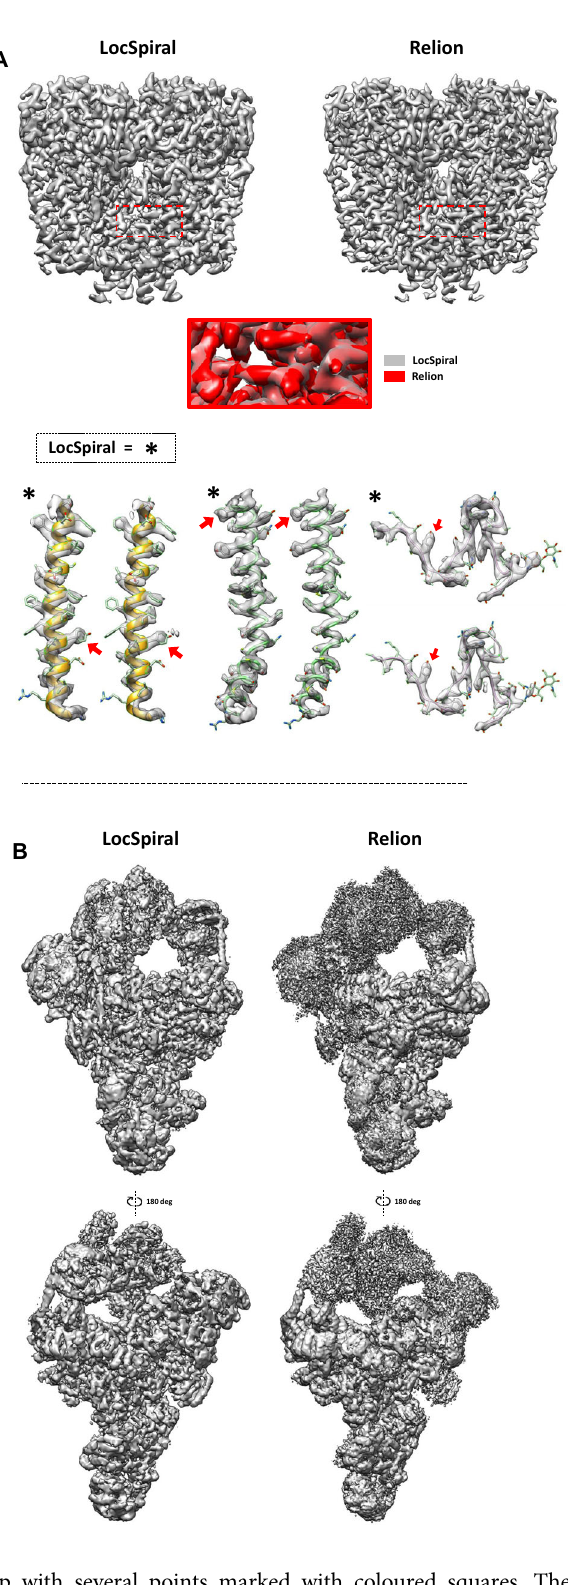
map with several points marked with coloured squares. These points show parts of the map that correspond to clear spliceosome densities (green and red), fl exible and low- resolution spliceosomal regions (yellow and blue) and back- ground (magenta). Figure 2B shows the corresponding Guinier plots at these locations. Solid lines represent measured values of the logarithm of SNR-weighted structure factor amplitudes, while